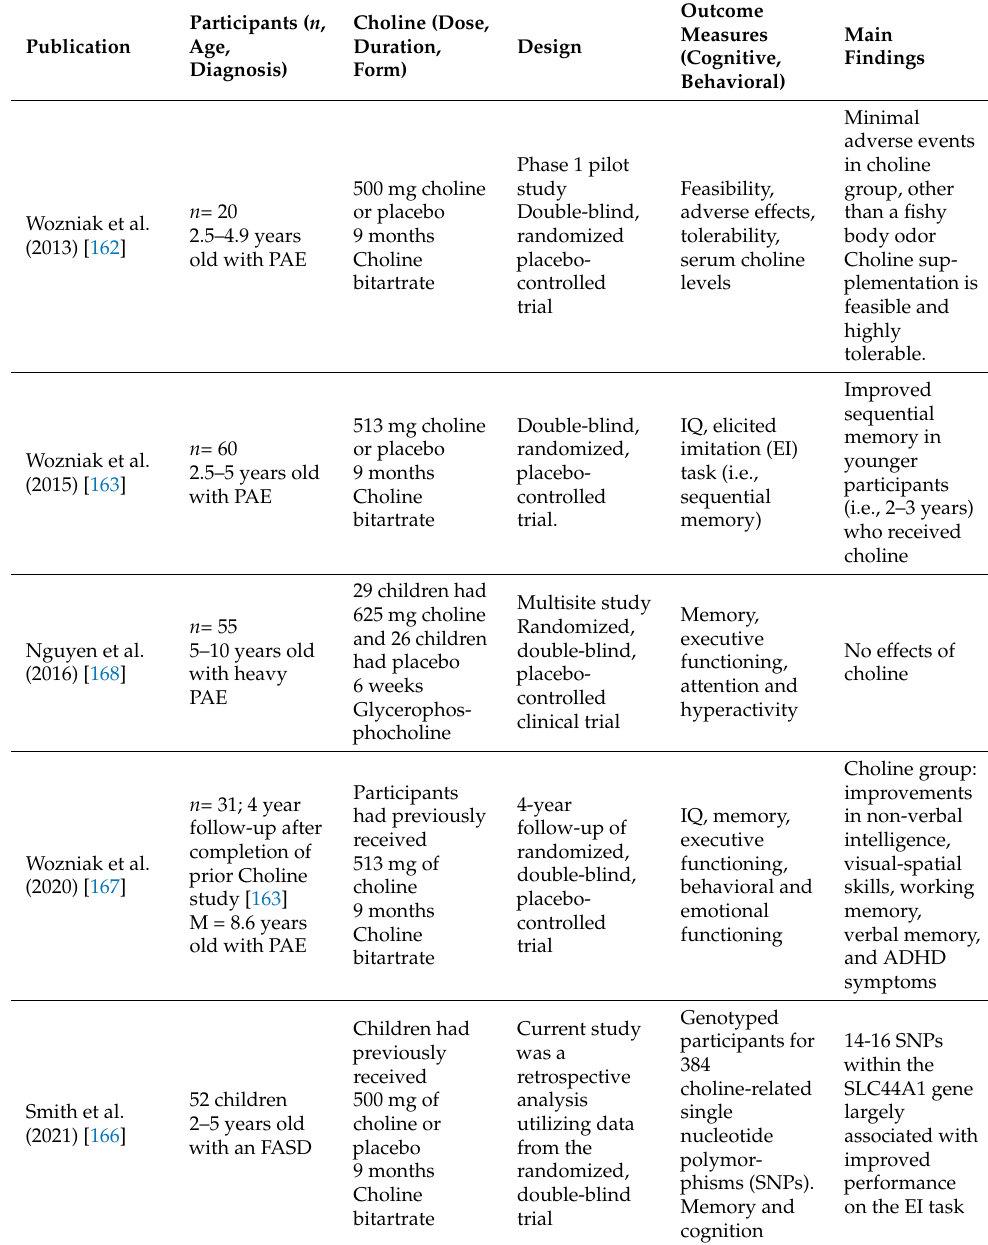
Table 2. Summary of postnatal choline supplementation